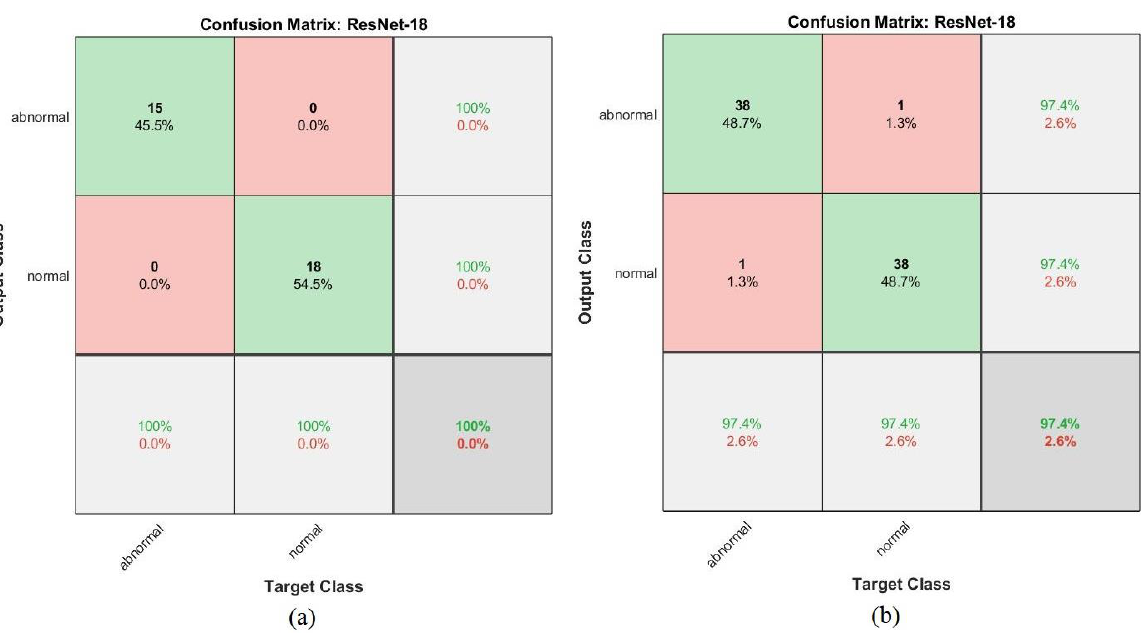
Figure 23. Confusion matrix for the GoogLeNet model for the ( a ) ALL_IDB1 and ( b ) ALL_IDB2 datasets.